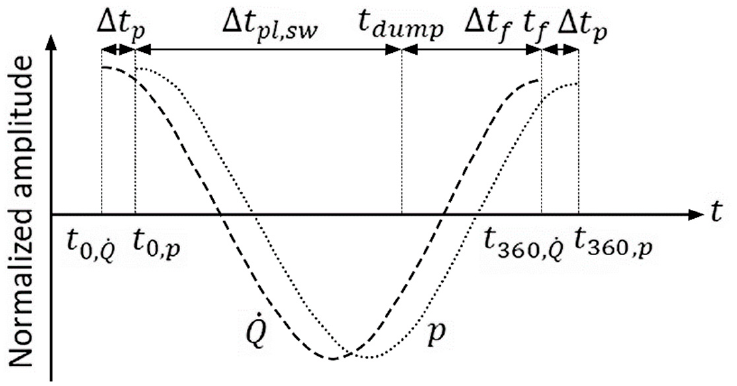
Figure 29. The scheme of the amplitude of pressure fluctuations in the fuel–air mixture flame.